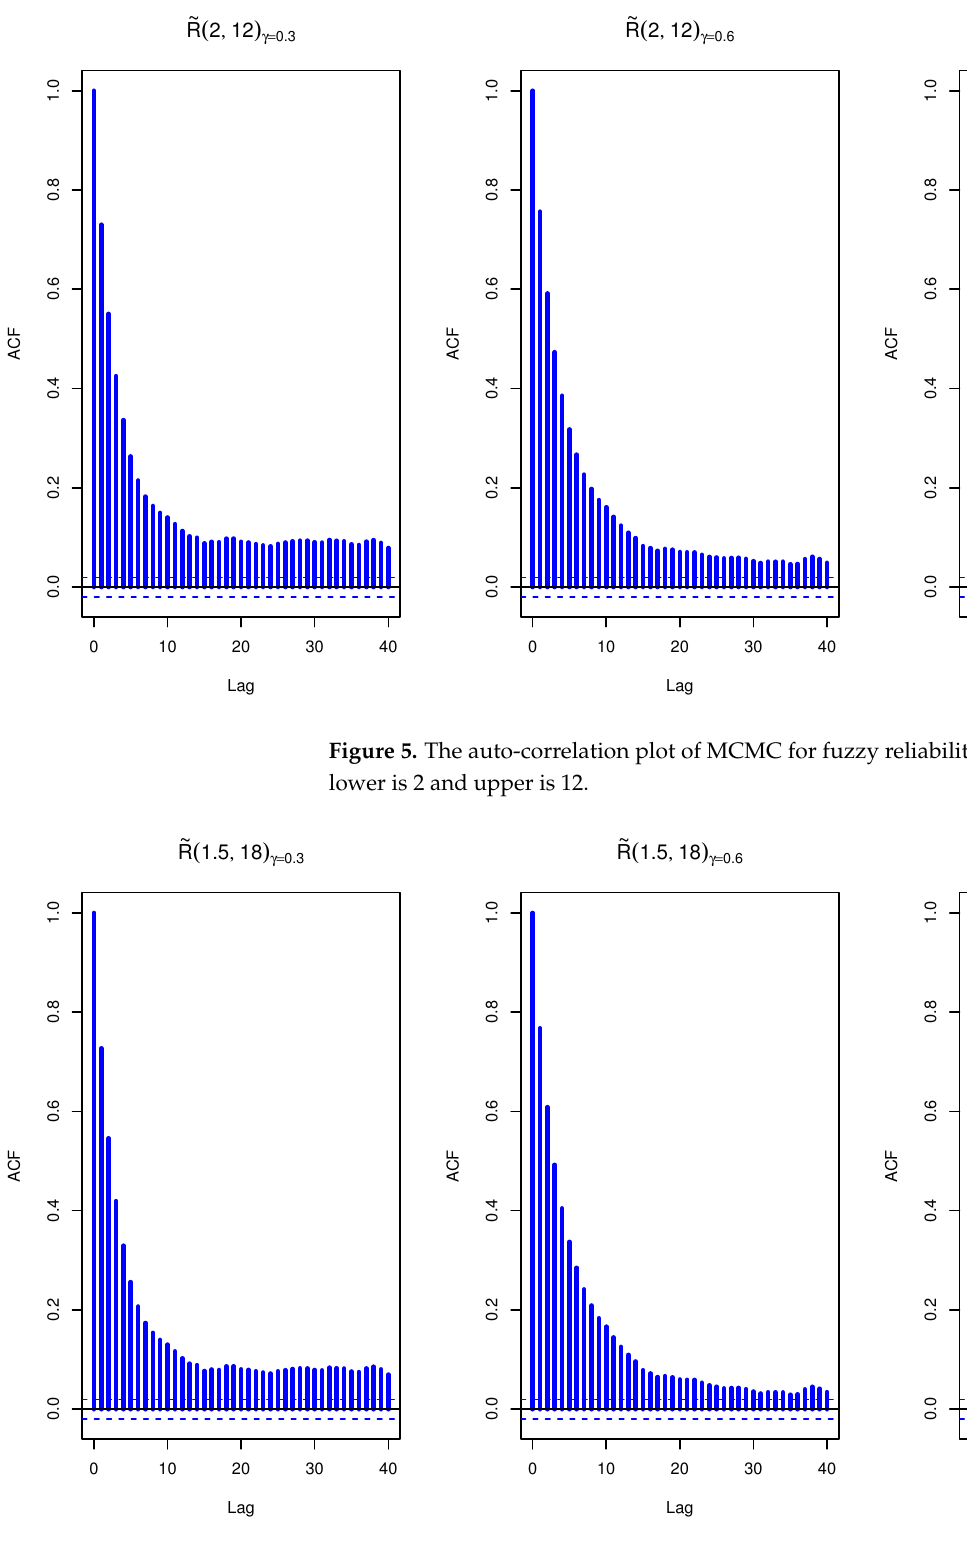
Figure 6. The auto-correlation plot of MCMC for fuzzy reliability ˜ R of TIIHLW distribution where lower is 1.5 and upper is